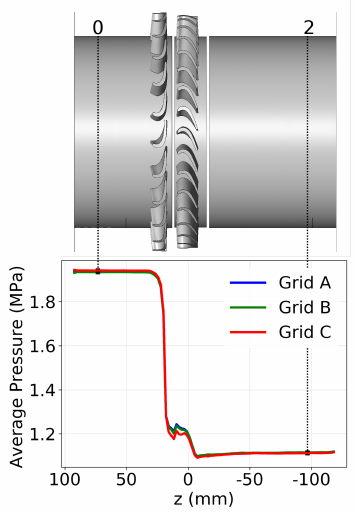
Figure 7. Azimuthally averaged pressure along the axial direction for Grids A–C after statistical convergence is achieved.